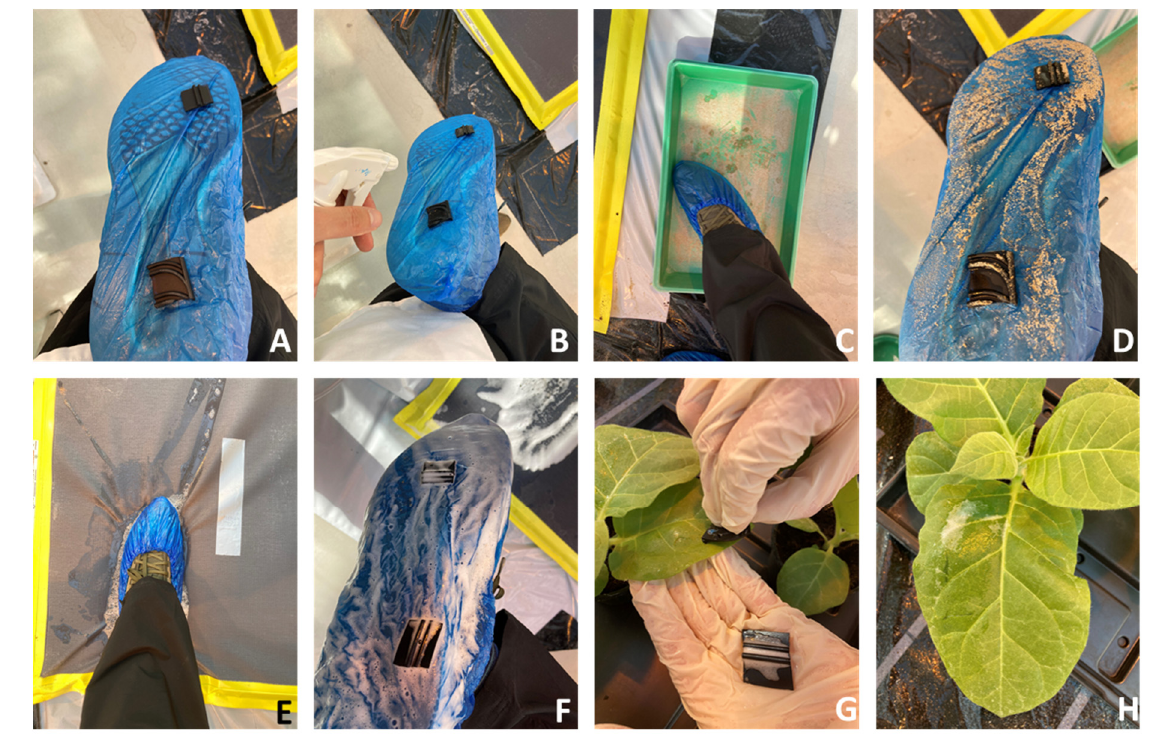
Figure 1. Illustration of boot disinfection under practical conditions. ( A ): germ carriers attached to disposable shoe covers, ( B ): germ carriers lightly moistened using a spray bottle, ( C ): step in the propagation crate with quartz sand inoculum mixture, ( D ): ToBRFV-contaminated germ carriers, ( E ): boot with the adherent germ carriers on the disinfection mat, where they are moved in a standardized manner, ( F ): germ carriers after disinfection, ( G ): inoculation of germ carrier on test plant to proof remaining infectiosity, ( H ): inoculated half leaf of a test plant.